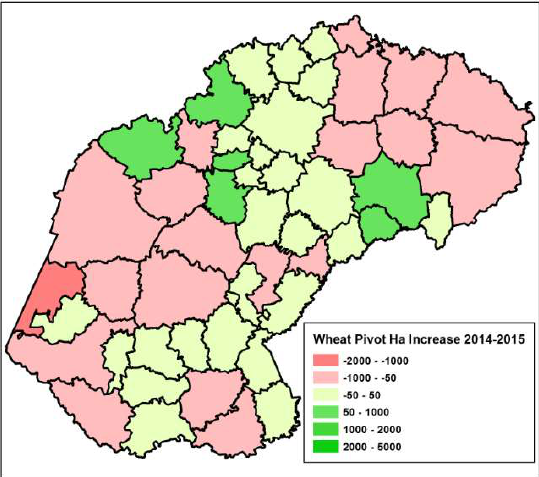
Figure 34. Maize in summer only under pivot irrigation increase or decrease per district between 2010 and 2014